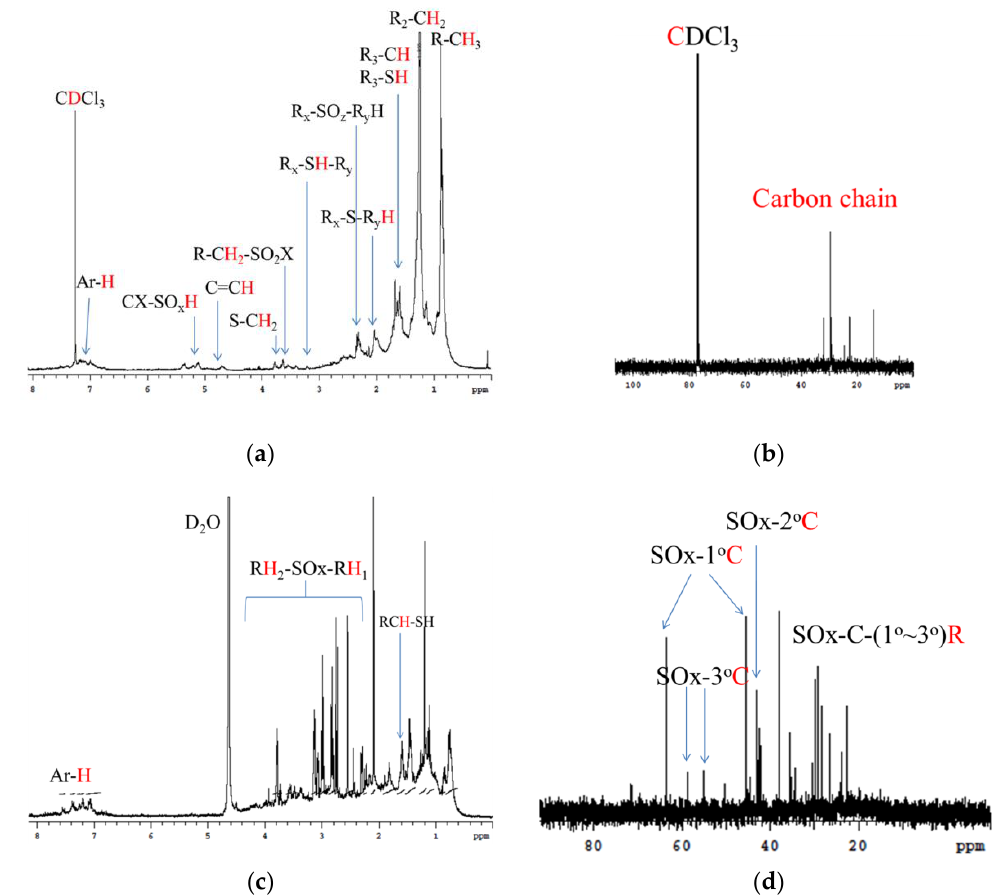
Figure 6. NMR spectra of cracking oil. ( a ) 1HNMR in CDCl 3 ; ( b ) 13 C NMR in CDCl 3 ; ( c ) 1HNMR in D 2 O; and ( d ) 13 C NMR in D 2 O. Samples in ( a ) and ( b ) were extracted with acetone; ( c ) and ( d ) were extracted with water; 1~3 o C means the degree of carbon.